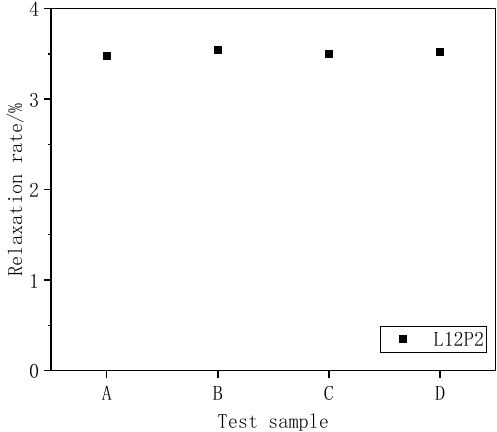
Figure 3. Test results of relaxation rate of L12P2 specimen.